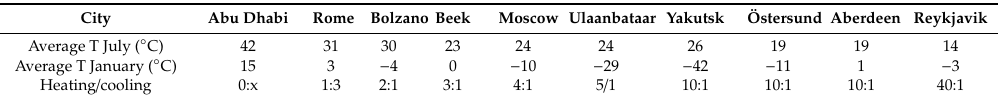
Figure 5. Annual energy consumption for heating, cooling and lighting for residential building equipped with double clear glazing at all studied locations. Table 2. Locations modelled in this study with average summer and winter temperature and ratio between annual heating and cooling demand.